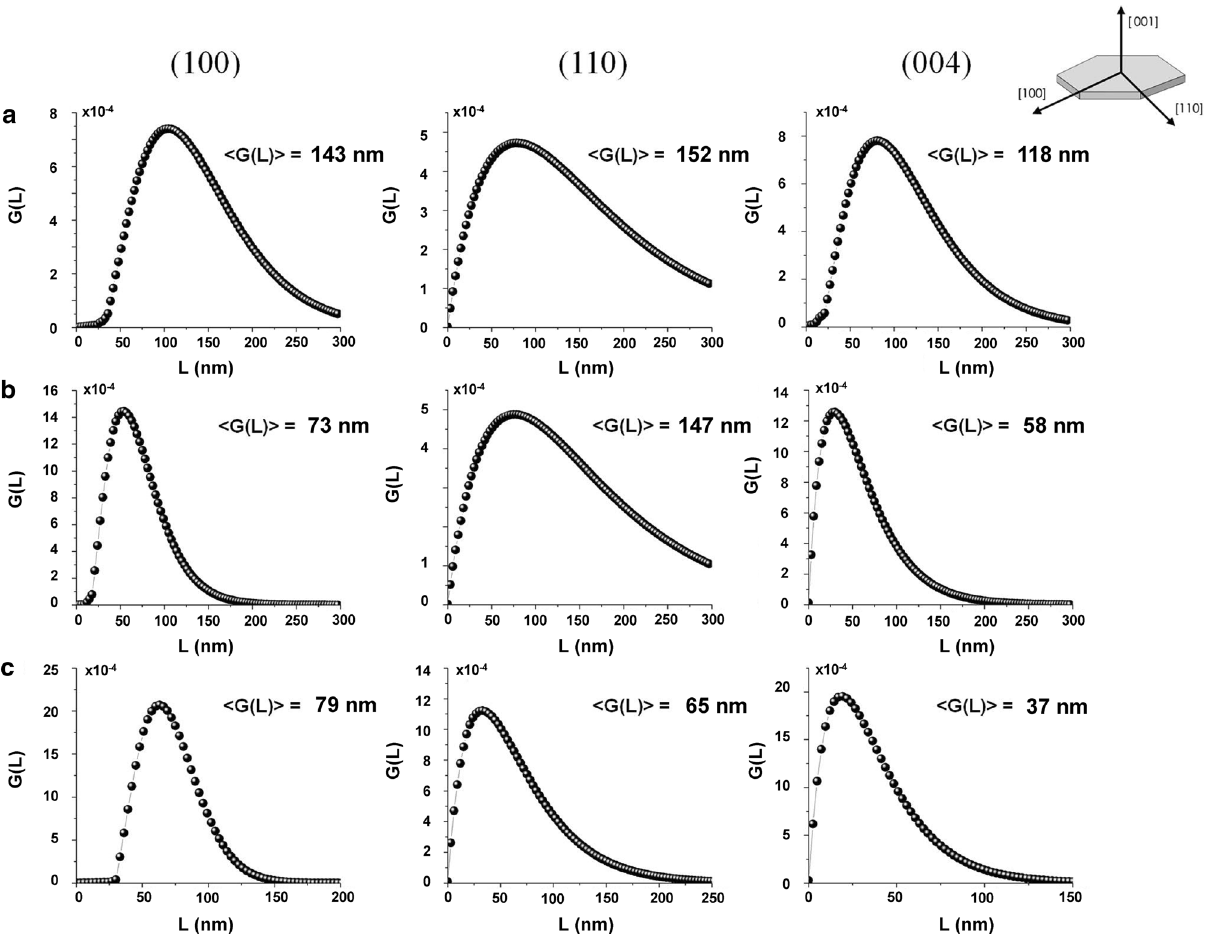
Figure 4. Volume-weighted crystallite size distribution G(L) for selected reflections (100), (110), (004), of ( a) SFO A , ( b ) SFO B , ( c ) SFO C